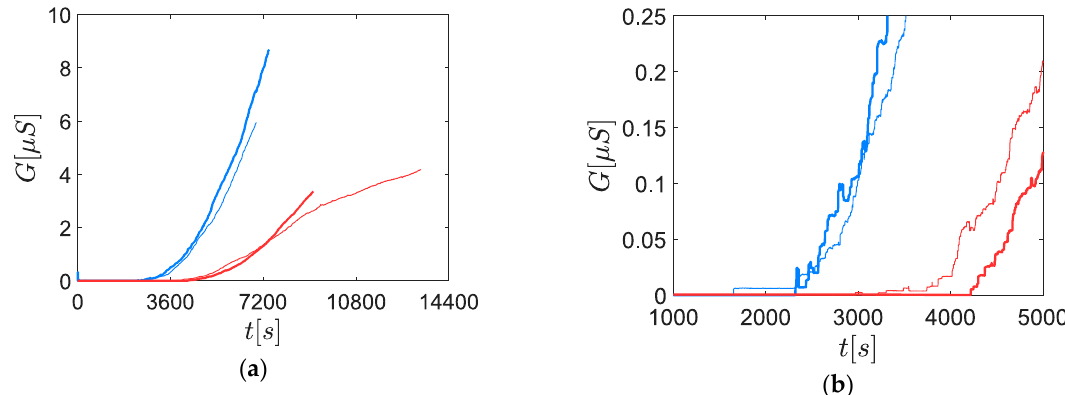
Figure 9. Soot sensor responses of two aerodynamically classified aerosols. Red curves: 50 nm aerosol; blue curves: 70 nm aerosol. The different responses are differentiated by their line width. The polarization tension is V pol = 60 V for each experiment. ( a ) Overview; ( b ) zoom on the percolation time.